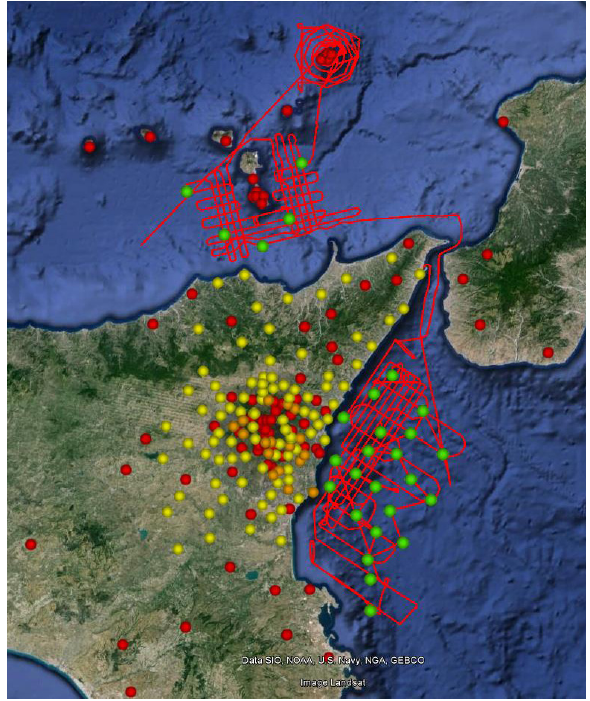
Figure 1. Map of Sicily and Aeolian islands. Locations of short pe- riod seismic stations (yellow dots), INGV permanent stations (red dots), broadband stations (orange dots) and ocean bottom seis- mometers (green dots) are shown. The shooting lines of the vessel are depicted with red